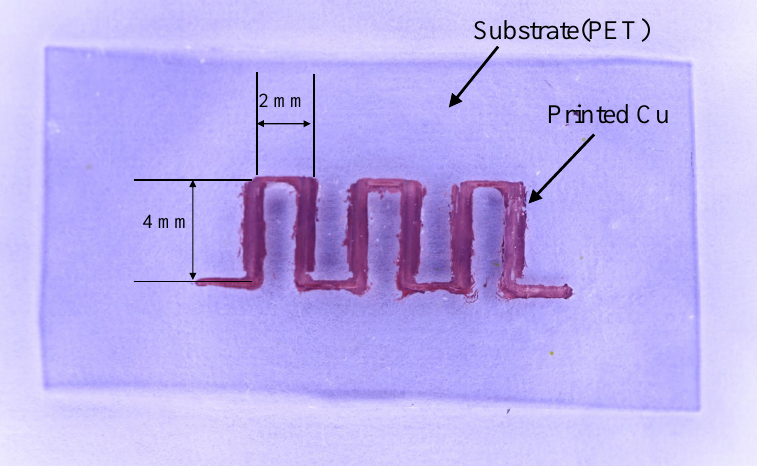
Figure 11. A “pulse signal” pattern printed on the PET